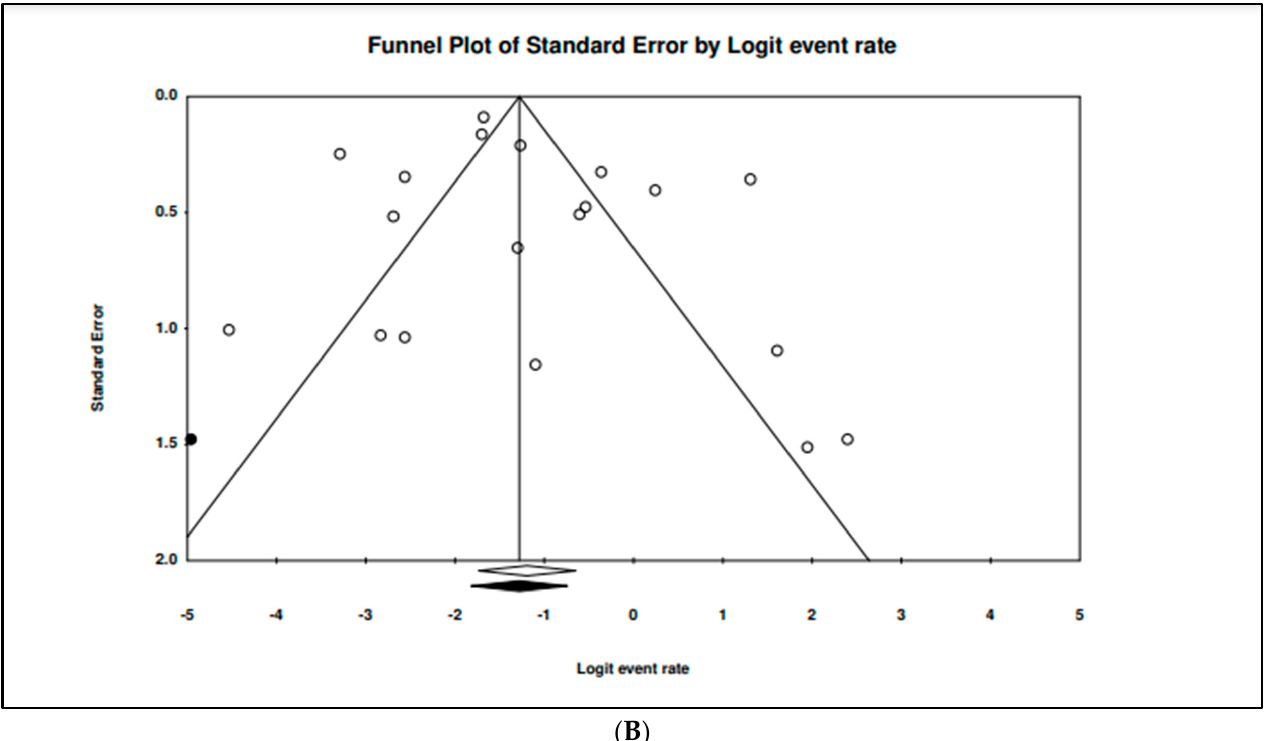
Figure 10. Funnel plot showing ( A ) publication bias in studies reporting the prevalence of parC gene in antimicrobial resistant S. Typhi and ( B ) result after performing trim-and-fill method where one missing study (closed circles) were added on the left side of the mean effect. Table 5. Sub-group analysis of prevalence parC gene in S. Typhi according to countries and regions.